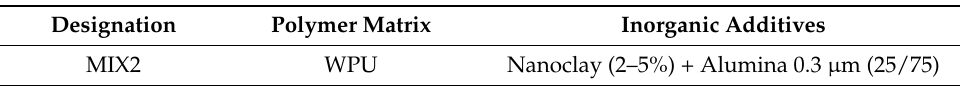
Table 3. Composition of the developed coating, MIX2.